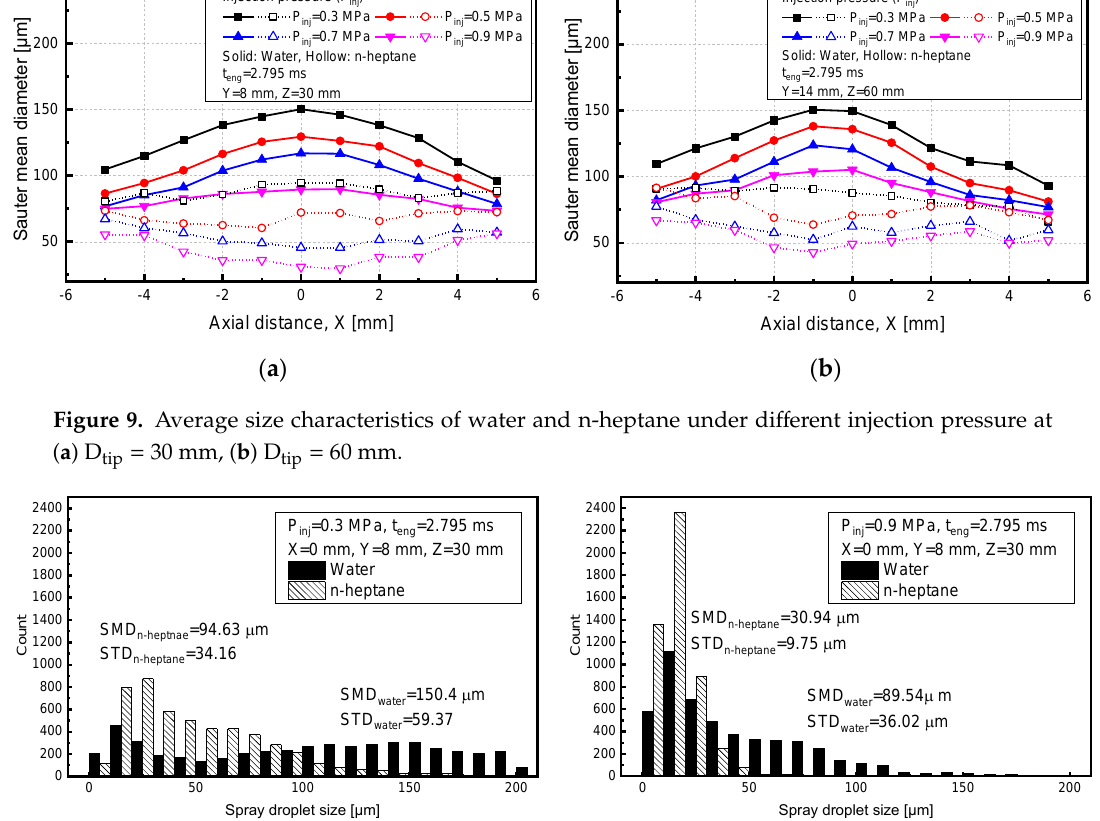
( b ) Figure 11. Comparison of distribution correlation of droplet velocity and size of water and n-heptane at ( a ) P inj = 0.3 MPa, ( b ) P inj = 0.9 MPa.